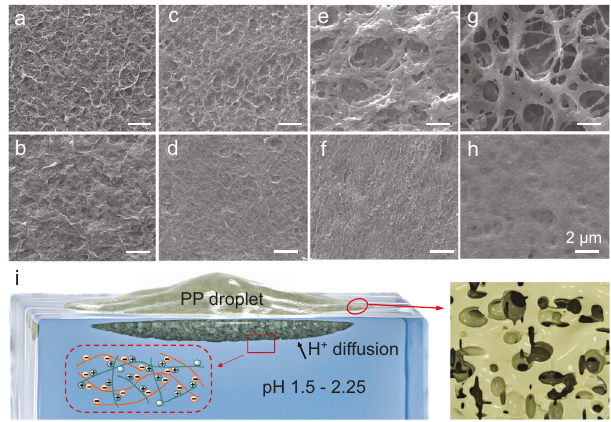
Fig. 3 Structure characterizations of PPMs. Cryo-SEM images of ( a , b ) PPM2.25, ( c , d ) PPM2, ( e , f ) PPM1.75, and ( g , h ) PPM1.5. All scale bars are 2 μ m. Images in ( a , c , e , g ), and ( b , d , f , h ) are top (contacting with air) and bottom (contacting with water) surfaces of PPMs, respectively. i A scheme illustrating the SWOW spreading and structures of PEI-PSSNa solution. Note: PP droplet means PEI-PSSNa solution placed on acidic water: (1) the surface spreading driven by surface tension, (2) the intrinsic water-in-water mixing, and (3) the pH- dependent PEI-PSSNa complexation. The surface tension differ- ence ( Δ γ ) between water ( γ w ) and PEI-PSSNa solution ( γ s ) represents the driving force of SWOW spreading (Eq. 1). Note- worthy, the value of γ w would vary slightly during the spreading of PEI-PSSNa solution, and the γ w is measured to be 74 ± 0.5 mN/m (> γ s ) when the spreading is fi nished. Here, the static γ w , instead of dynamic γ w , was used to qualitatively analyze the effect of Δ γ in the maximum diameter of PPMs (Eq. 1). As discussed above, the PEI-